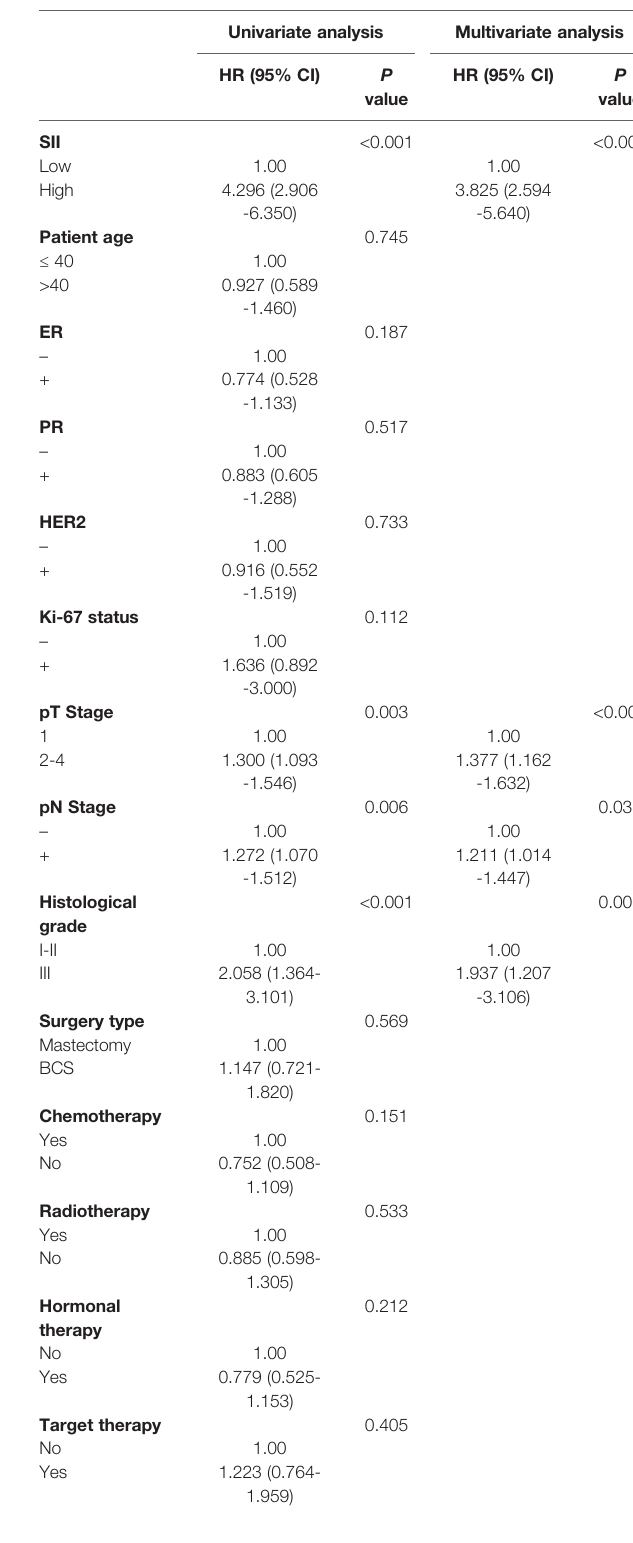
TABLE 3 | Results of the analysis of the prognostic factors for overall survival. Univariate